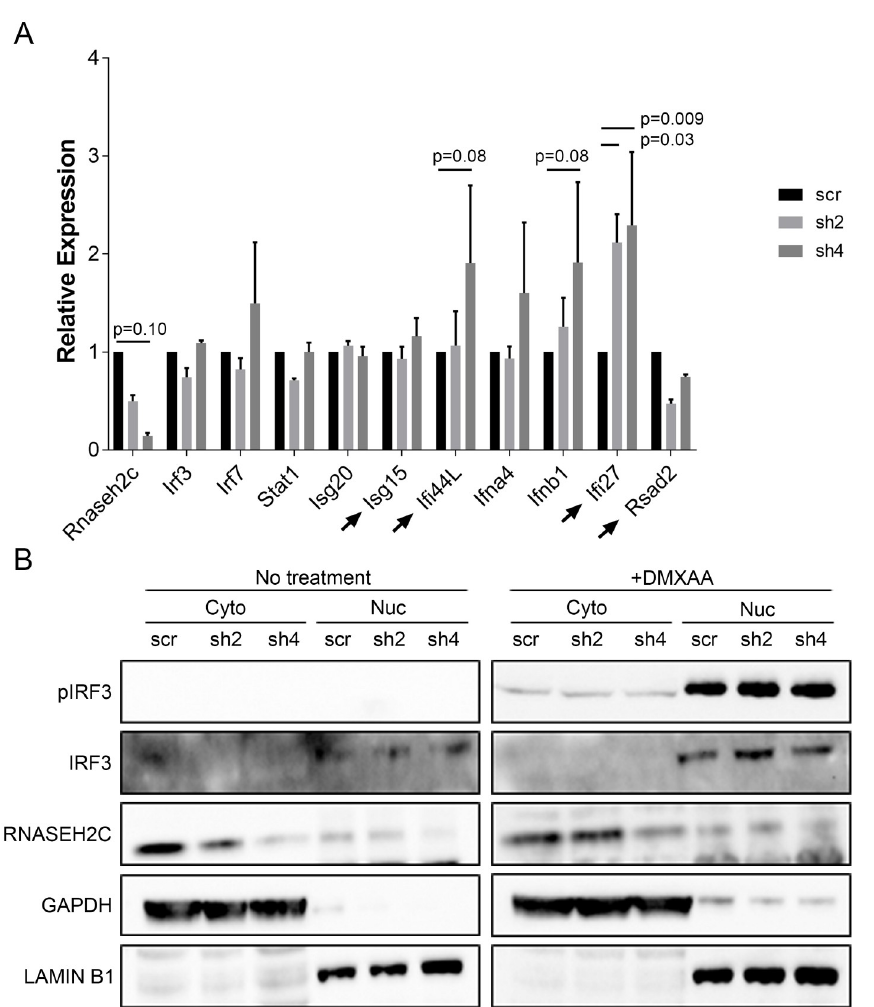
Fig 5. IRF3 signaling, the proposed AGS mechanism, is not activated in Mvt1 Rnaseh2c knockdown cells. (A) qPCR analysis of a panel of interferon stimulated genes in response to Rnaseh2c knockdown. Arrows indicate genes that are upregulated in AGS. Average ± standard error of three experiments. (B) Western blot analysis of IRF3 phosphorylation and nuclear translocation in Rnaseh2c knockdown cells following fractionation of the cytoplasmic (Cyto) and nuclear (Nuc) fractions. Sting activation using treatment with DMXAA was used as a positive